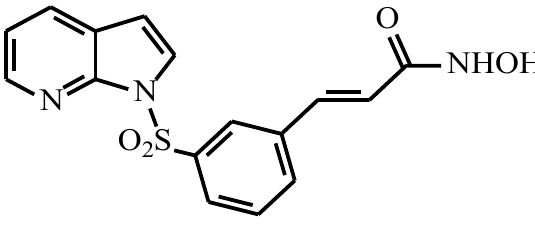
Figure 1. Chemical structure of MPT0B291, with molecular weight 343.36 g/mol.